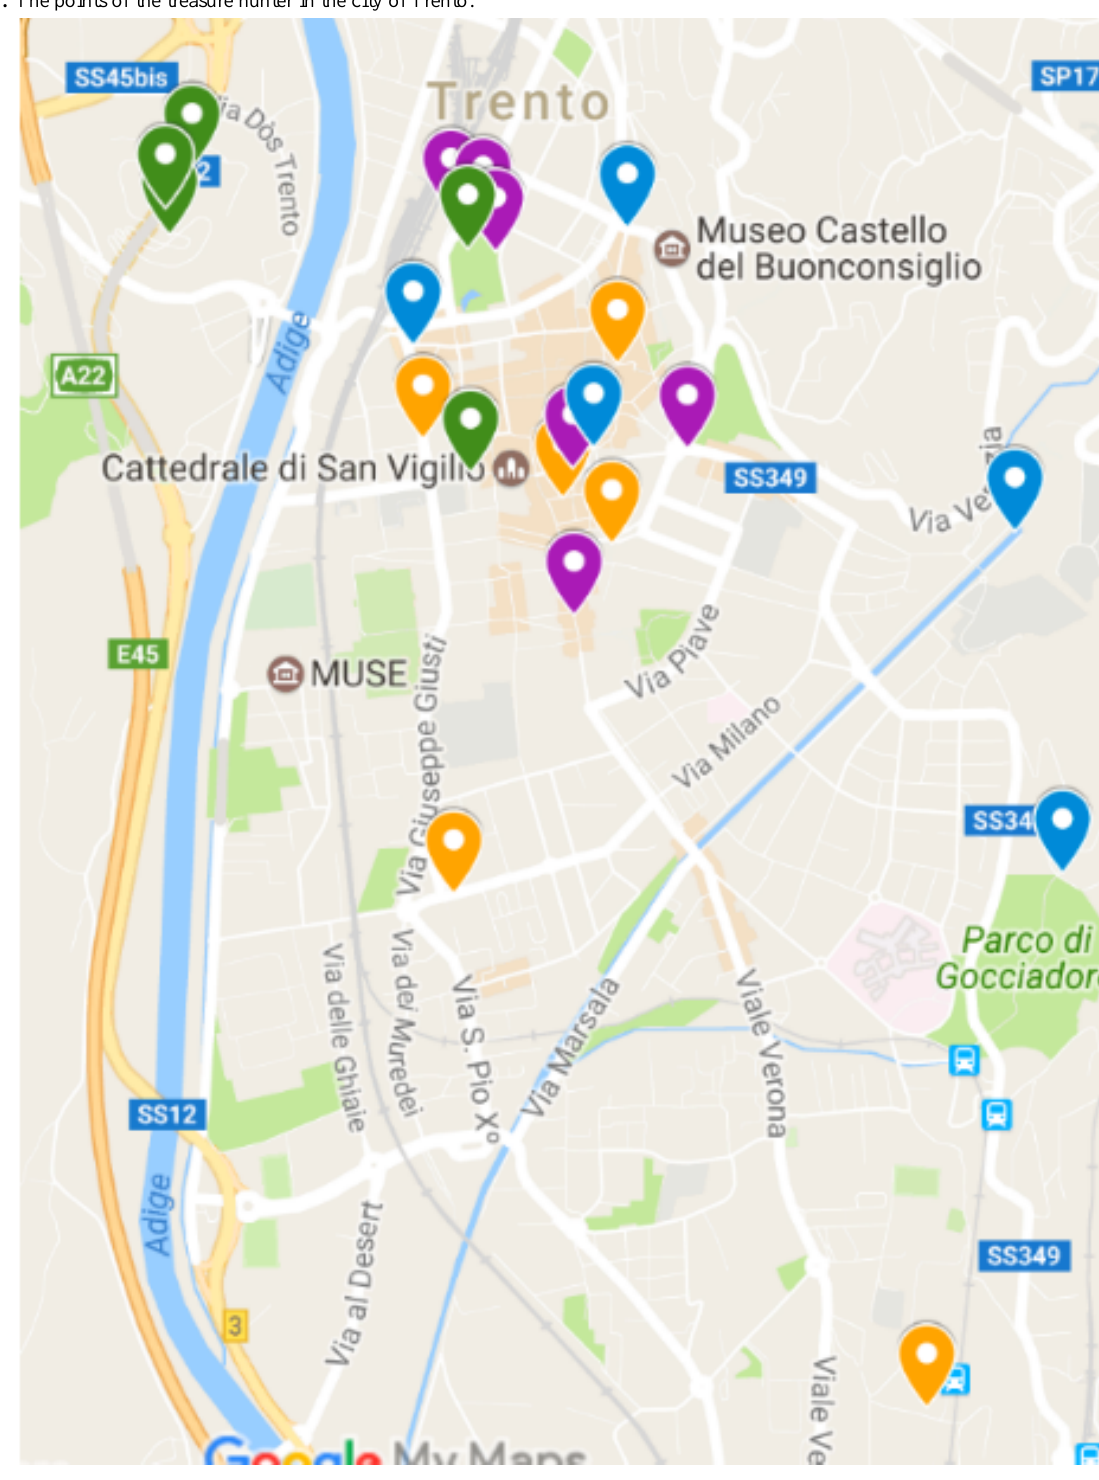
Figure 3. The points of the treasure hunter in the city of